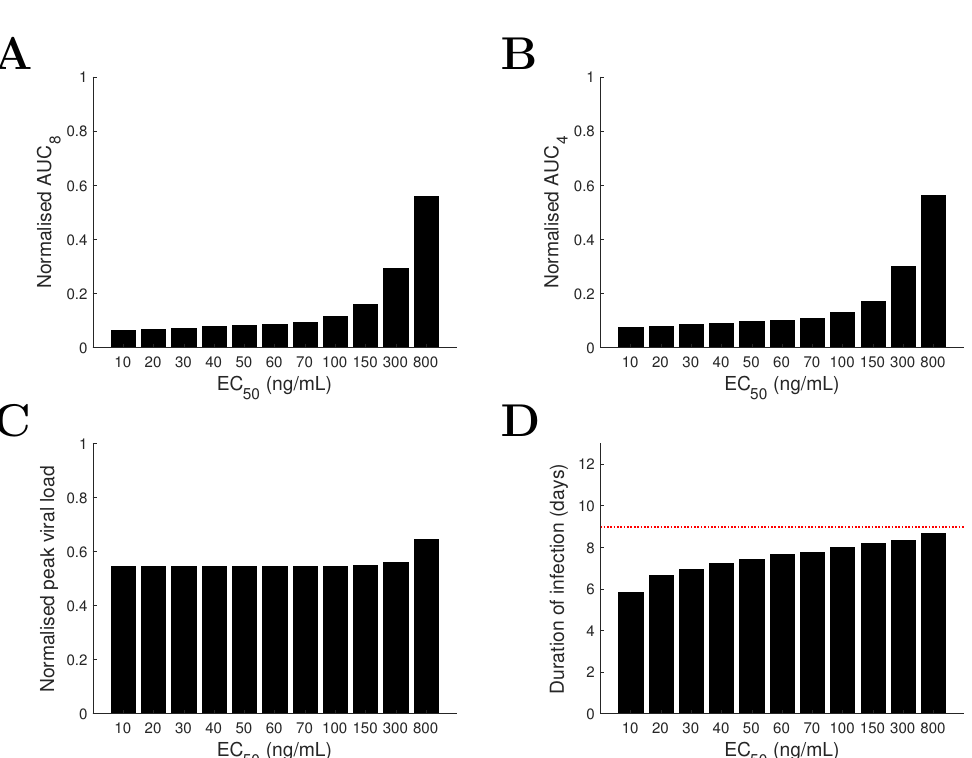
Figure 7. Dependence of infection-related quantities on drug efficacy for the IR model. As drug efficacy EC 50 varies from 10 ng/mL to 800 ng/mL, infection-related quantities, AUC ( A , B ), peak viral load ( C ) and duration of infection ( D ), are shown in different panels. AUC 8 , AUC 4 and peak viral load are normalised to their corresponding quantities in the no-drug control. The duration of infection without antiviral treatment is indicated by the dotted red line in panel D